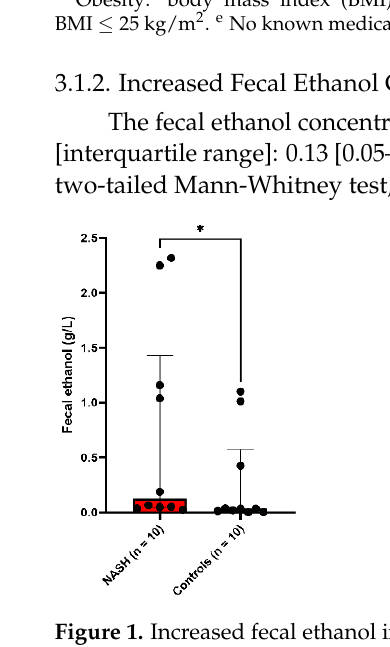
Figure 1. Increased fecal ethanol in NASH patients. * p < 0.05.